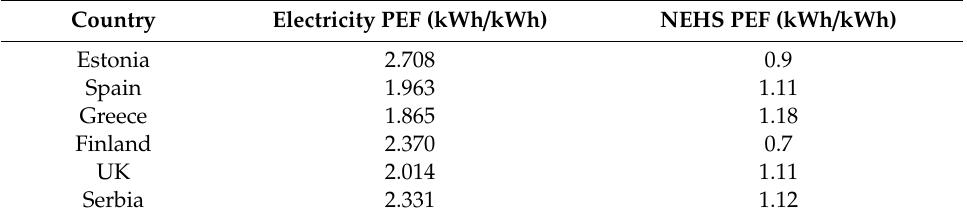
Table 5. Summary table for the obtained PEF of the di ff erent countries’ electricity